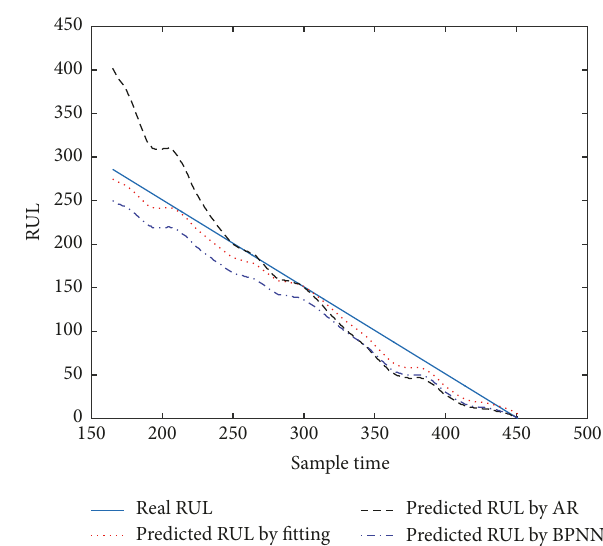
Figure 10: The online prediction result of the critical